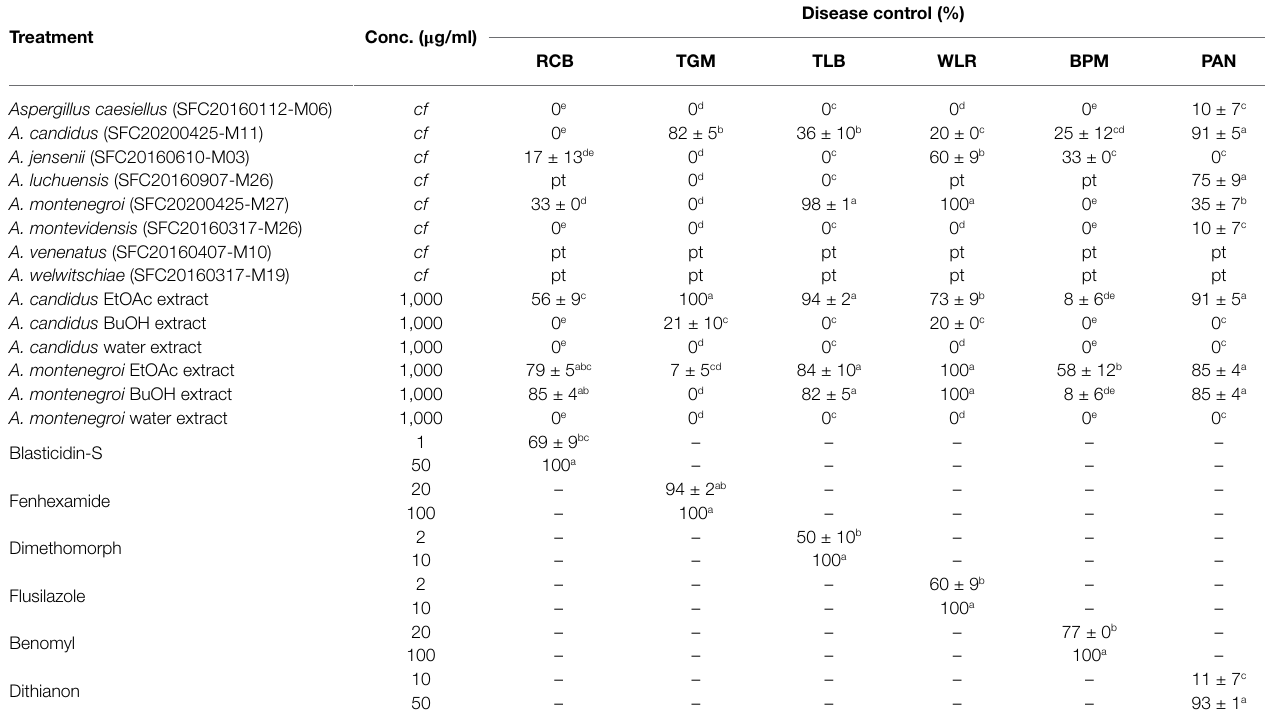
TABLE 1 | In vivo antifungal activity of Aspergillus species against plant pathogenic fungi.